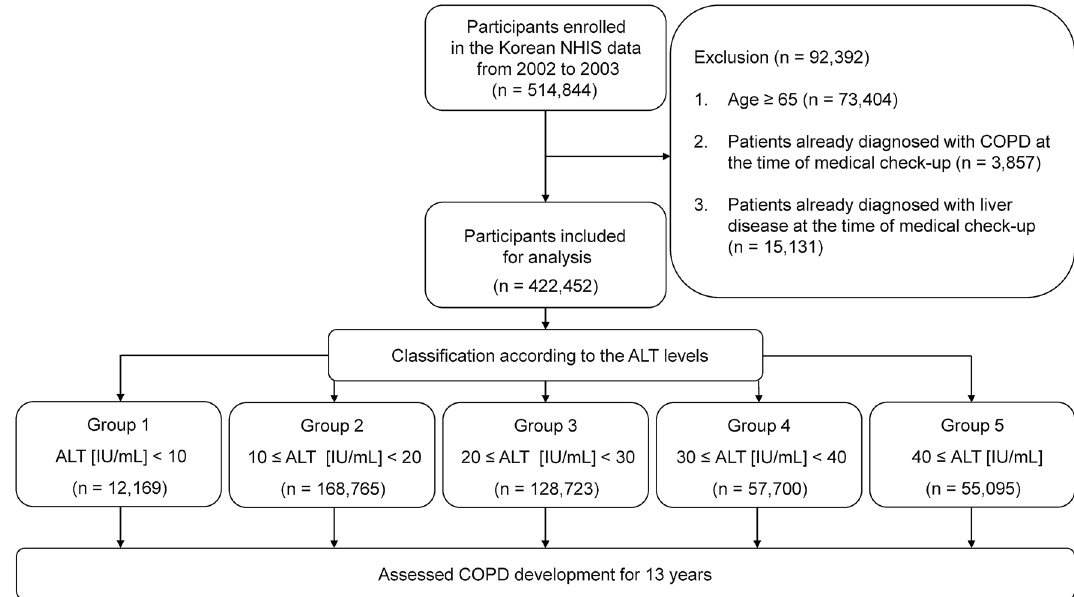
Figure 5. Study flowchart. ALT alanine aminotransferase, COPD chronic obstructive pulmonary disease, NHIS National Health Insurance